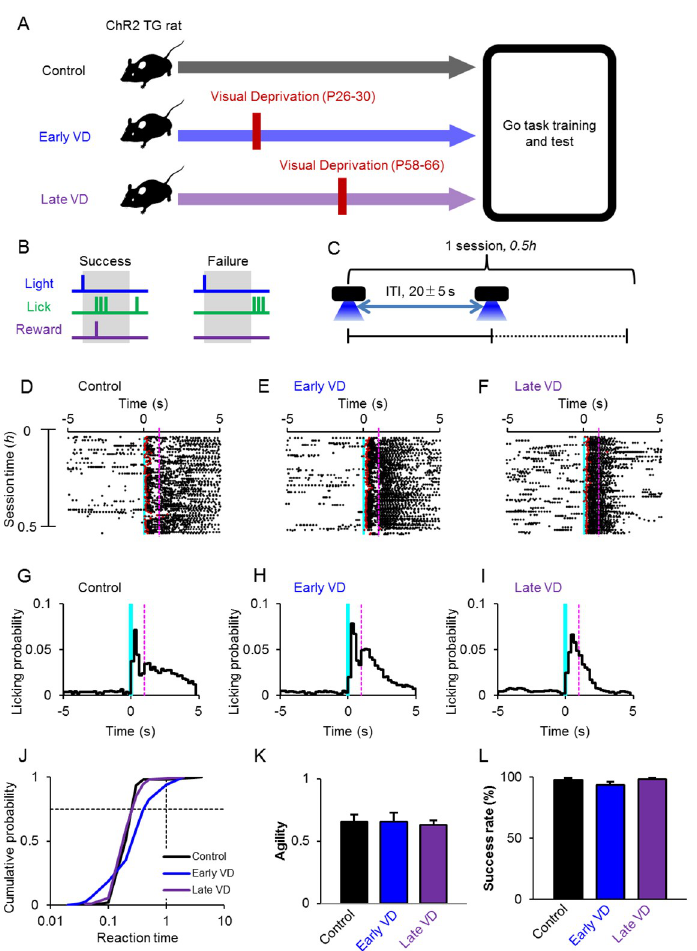
Fig 2. Establishment of the optogenetic conditioning. A , Experimental protocol. B , Go task paradigm. The rat was rewarded when it licked the nozzle within the 2-s time window (success, left), but not when it did not lick within the time window (failure, right). C , The LED stimulus was repeated with 20 ± 5 s inter-trial interval (ITI), one conditioning session was 0.5 h . D-F , Sample raster plots of the licking events 5-s before and after the onset of the LED stimulus cues (blue vertical line), the control (D), early VD (E), late VD (F) rats, respectively, while the red marks indicate the rewarded lick. G-I , Histograms of the licking probability before and after 5 s of the onset of LED stimulus cues (blue vertical line) of the same rats shown previously (D-F). J , Cumulative probability plots of the reaction time. The vertical broken lines was drawn at 1 s while the horizontal ones at 0.75. K , Summary of the agility: the control (n = 9), early VD (n = 10) and late VD (n = 8) groups. One-way ANOVA Turkey-Kramer post hoc test: p = 0.99 (the control vs. early VD); p = 0.95 (the control vs. late VD) and p = 0.95 (early vs. late VD). L , Summary of the success rate: the control (n = 9), early VD (n = 10) and late VD (n = 8) groups. One-way ANOVA Turkey-Kramer post hoc test: p = 0.3 (the control vs. early VD); p = 0.99 (the control vs. late VD) and p = 0.27 (early vs. late VD). In A-F, each magenta broken line was drawn at 1 s after the cue